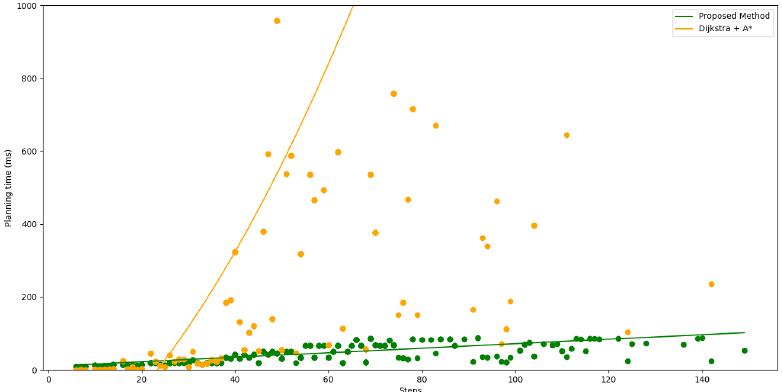
Figure 7. Speed comparison between the traditional algorithms and the proposed